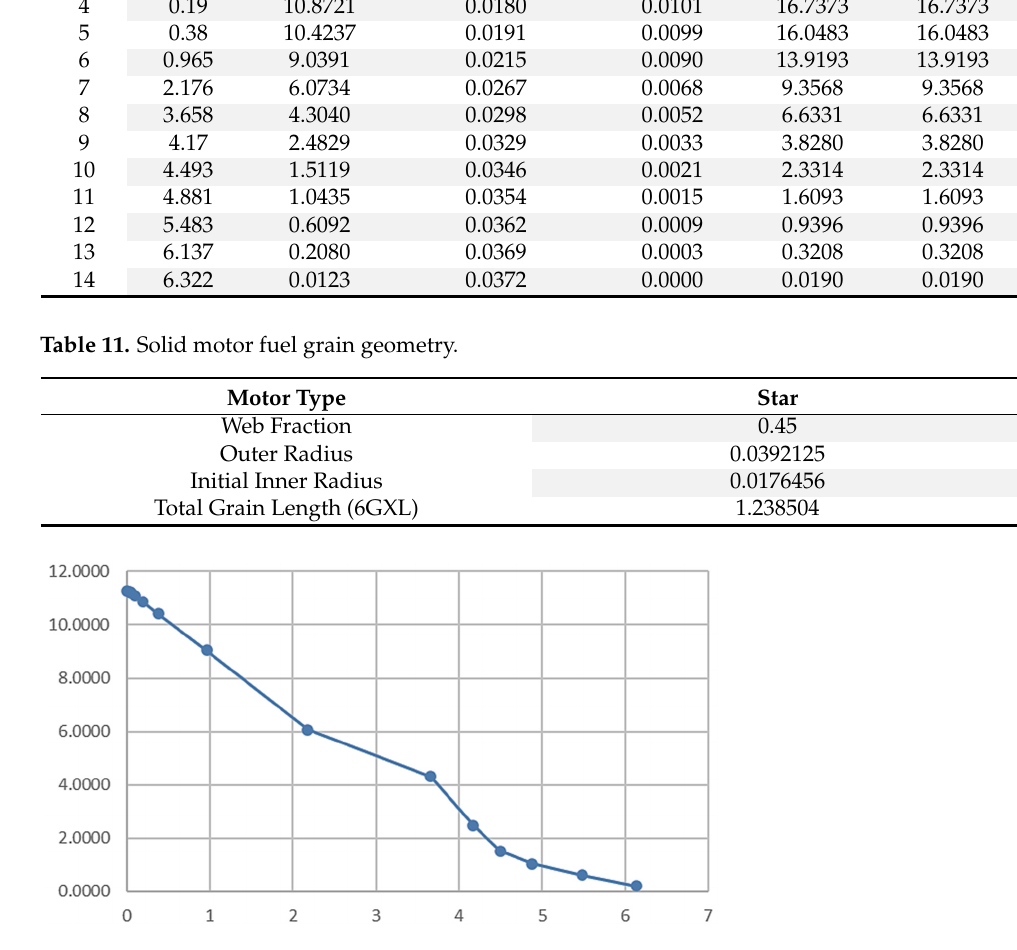
Figure 25. Motor mass over time.